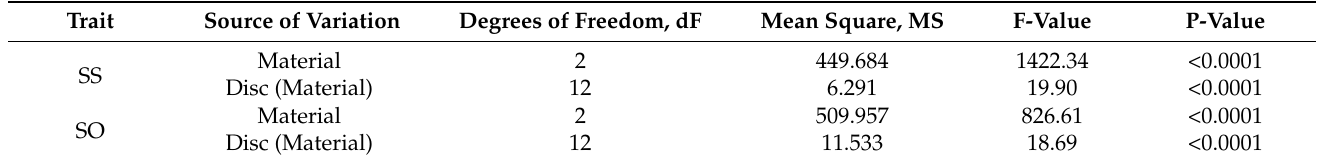
Table 1. Nested ANOVA analysis of significant differences between the materials and dentine discs in the central (SS) and peripheral (SO) zones.